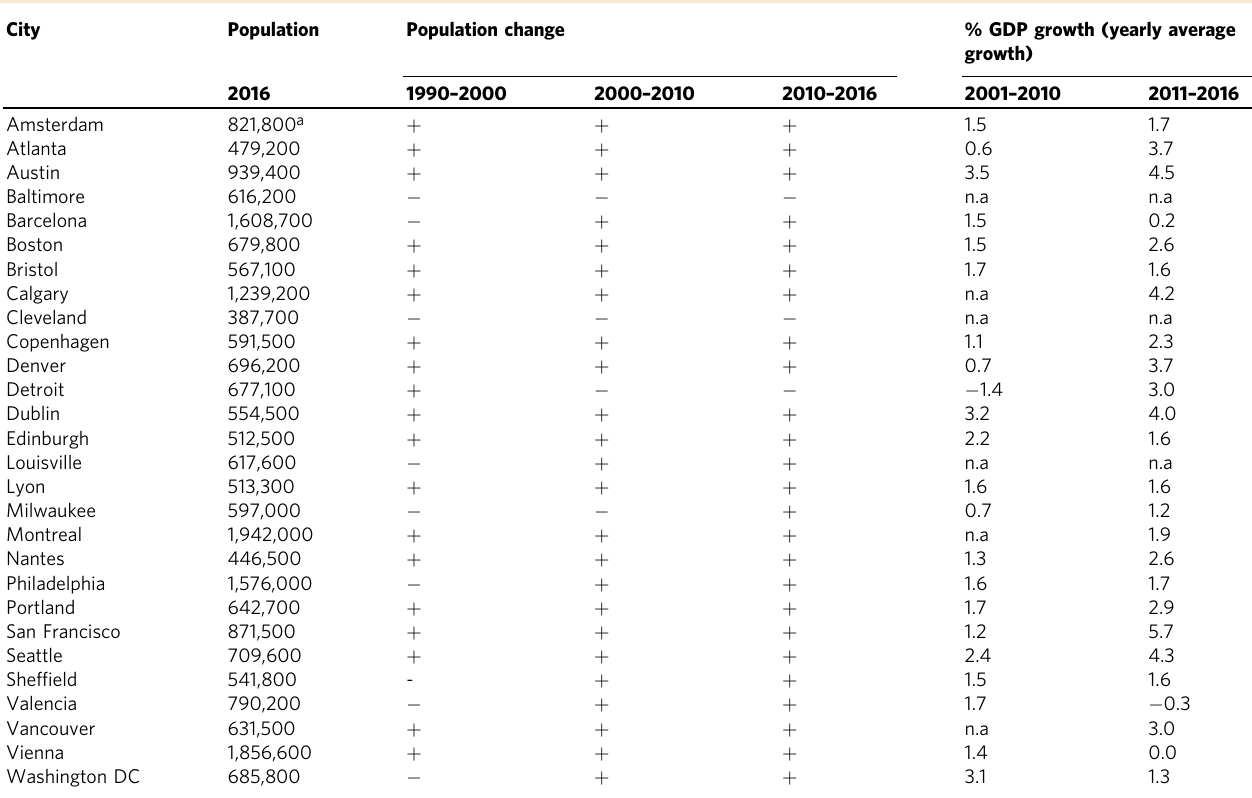
Table 2 Basic descriptive characteristics of cities included in the